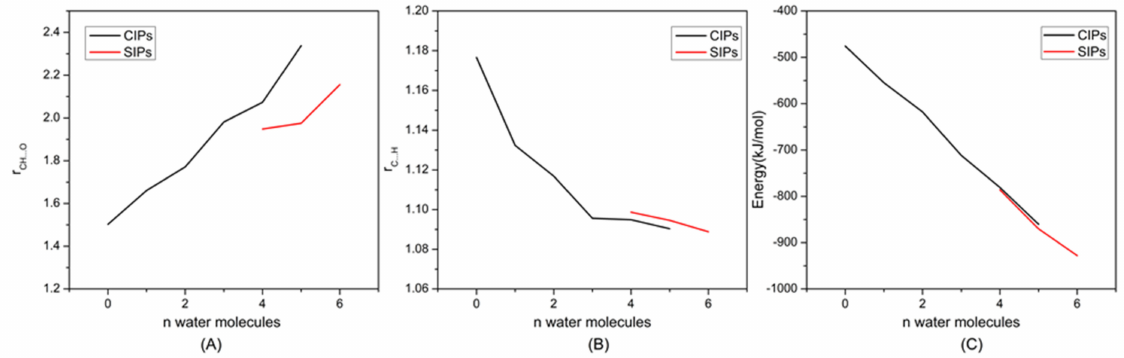
Figure 8. DFT calculated ( A ) intermolecular bond r CH ... O (anion) and r CH ... O (water); ( B ) in- tramolecular bond r C ... H of cation; ( C ) total binding energies for EmimOAc- n H 2 O ( n = 0–6) clusters.